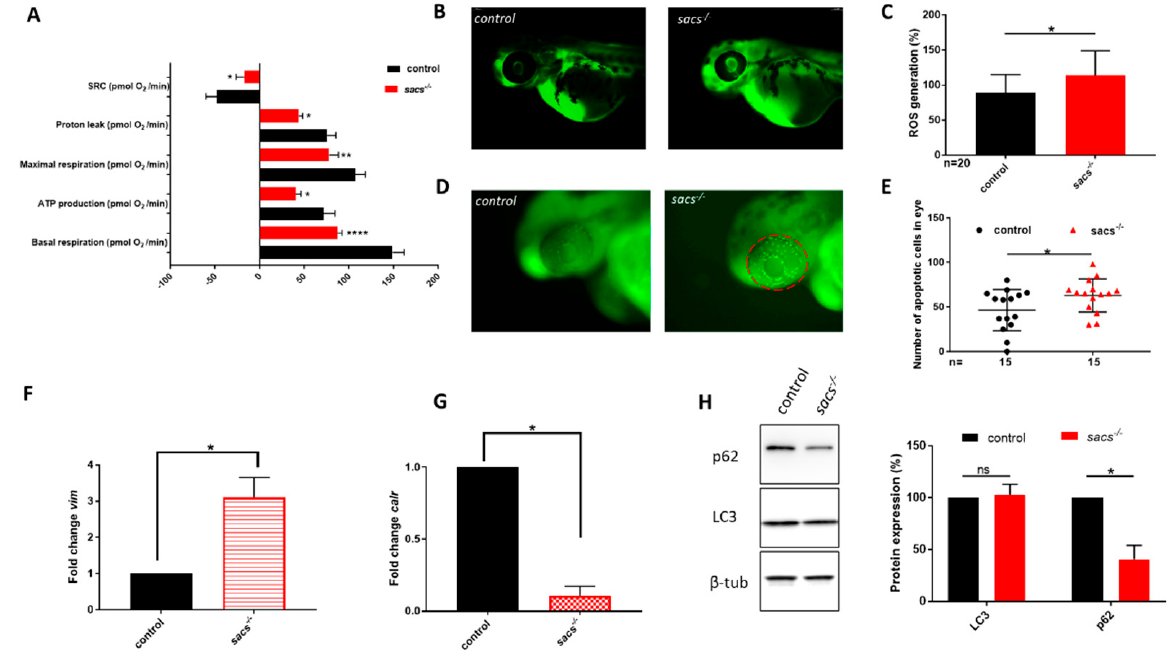
Figure 3. Sacs − / − mutant zebrafish manifest mitochondrial and autophagic dysfunction and ROS accumulation. ( A ) Mitochondrial respiratory analysis of controls ( n = 30) and sacs − / − mutant larvae ( n = 37) at 120 hpf. * p ≤ 0.05, ** p ≤ 0.01, **** p ≤ 0.0001, calculated by the Mann-Whitney test. ( B ) Representative fluorescence images of ROS generation in zebrafish larvae at 48 hpf. ( C ) Quantitative analysis of ROS generation. * p ≤ 0.05 was calculated by the Mann-Whitney test. The values are expressed as mean ± standard deviation (SD). ( D ) Detection of apoptotic cells by acridine orange staining at the level of the eye in controls and sacs − / − mutant embryos at 48 hpf (lateral views). Apoptotic cells were counted in the area defined by the red circle. ( E ) Quantitative analysis of apoptotic cells. * p ≤ 0.05 was calculated by the Mann-Whitney test. The values are expressed as mean ± standard deviation (SD). ( F , G ) qRT-PCR analysis revealed increases in vim and calr expression, once the mRNA expression levels had been normalized to β -actin . Three independent RNA samples from controls and sacs − / − mutant larvae at 120 hpf were analyzed. * p ≤ 0.05, calculated by Student’s t -test. ( H ) Three independent larval homogenates from controls ( n = 50) and sacs − / − larvae ( n = 50) were tested by Western blotting for the expression of p62 and LC3 proteins. The levels of the different proteins were normalized to β -tubulin. * p ≤ 0.05 was calculated by Student’s t -test. Abbreviations: n , number of evaluated embryos in total; error bars indicate standard error of the mean; ns, not significant; SRC, spare respiratory capacity; ROS, reactive oxygen